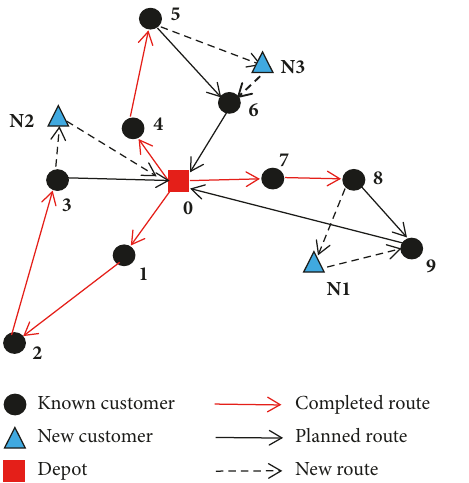
Figure 7: An example of the strategy of adding new customers to known routes.